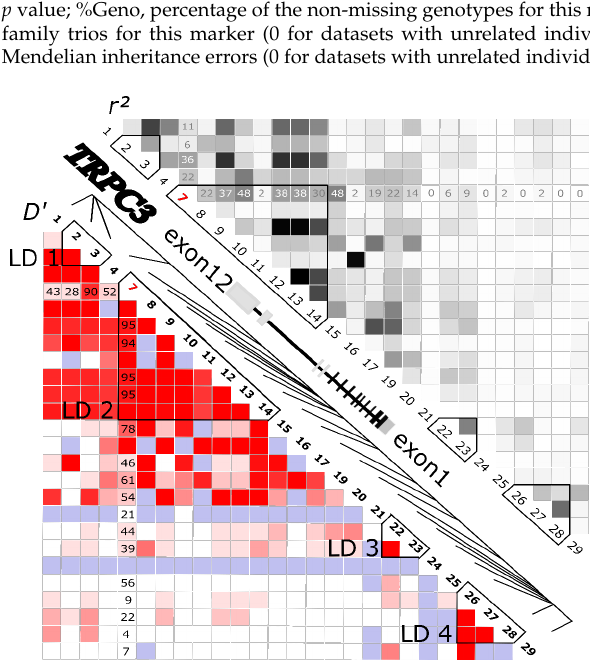
Figure 1. Schematic representation of the TRPC3 gene structure and the LD. The gene structure of the TRPC3 gene is shown with exons 1 – 12. The four linkage disequilibrium (LD 1–4) blocks were generated from 29 SNPs using the LD statistics and HaploView. Linkage dis- equilibrium was measured using the D’ and r 2 correlation coefficients and is displayed according to the standard color schemes for D ’ (white: LOD < 2; D ’ < 1; blue: LOD < 2; D ’ = 1; shades of pink/red: LOD ≥ 2; D ’ < 1; bright red: LOD ≥ 2; D ’ = 1) and r 2 (white: r 2 = 0; shades of gray: 0 < r 2 <1; black: r 2 = 1). The D ’ × 100 and r 2 × 100 values of only the SNP pairs between rs11726196 (#7, red) and other SNPs are shown in each cell. Empty cells between these pairs of SNPs in the standard color scheme indicate D ’ = 1. Red #7 indicates the tag SNP rs11726196. We further analyzed the associations between these tag SNPs and the chronic pain status. Even after correcting for multiple testing, such as the Bonferroni adjustments with the number of SNPs (the significance level after the Bonferroni correction was p < 0.0033 [0.05/15]), the genotype distribution for the rs11726196 SNP in the patient subjects was significantly different from the control subjects in the genotypic model (Pearson χ 2 test, p = 0.00089 ; Table 2). This result suggests that rs11726196 is significantly associated with chronic pain. No other SNPs were significantly associated with the chronic pain status (Table 2). Table 2. Associations between the tag SNPs in and around the TRPC3 gene and chronic pain, com- paring the genotype distributions between patients and control subjects.